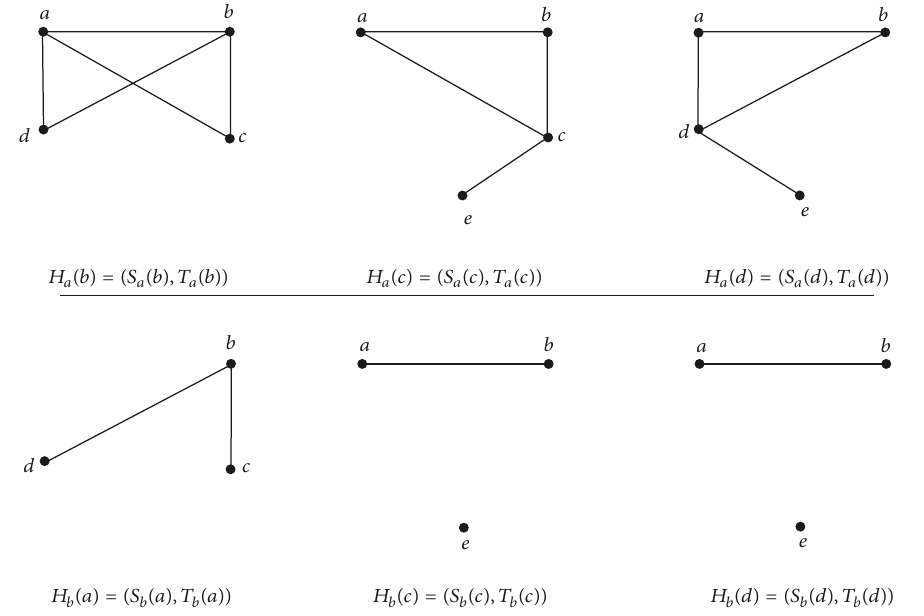
Figure 2: 𝐺 ∗ = (𝐻 ∗ (𝑎),𝐻 ∗ (𝑏))